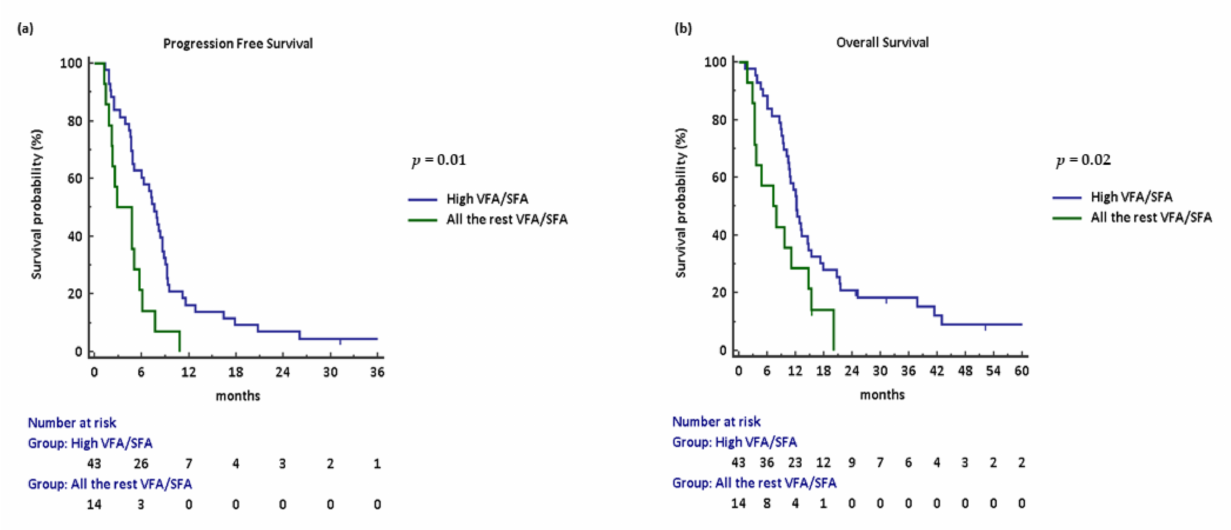
Figure 1. Kaplan–Meyer curves according to VFA/SFA ratio: ( a , b ) progression-free and overall survival stratified by high vs. all the rest, respectively. Abbreviations: VFA/SFA, visceral fat area/subcutaneous fat